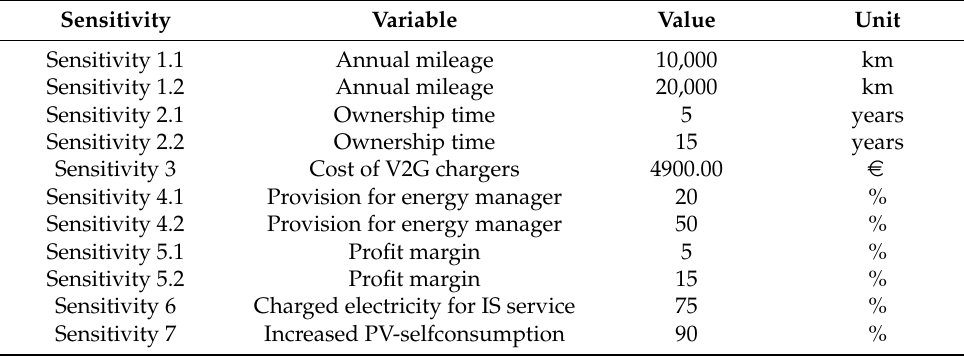
Table 12. Changed parameter used for sensitivity analysis (source: own compilation). Sensitivity Variable Value